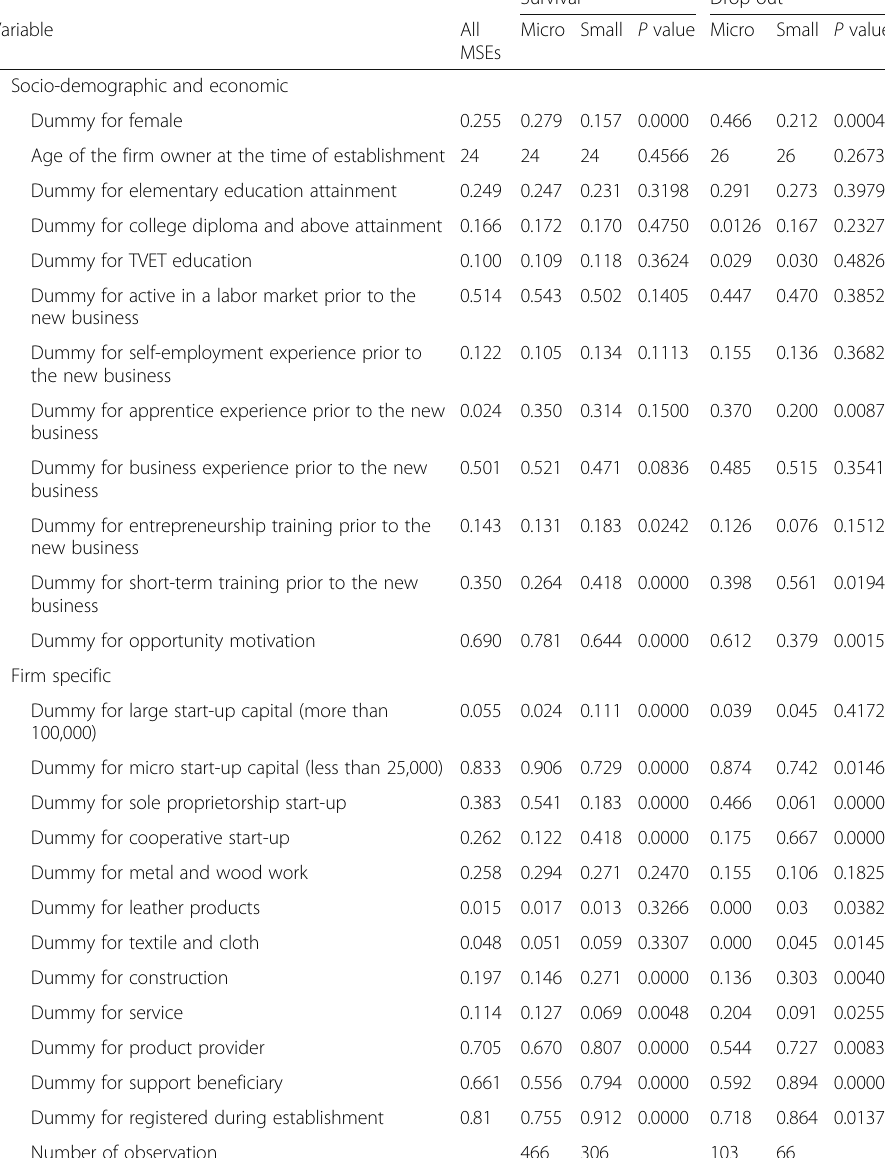
Table 2 Mean separation test in the survival rate of firms between micro and small enterprises